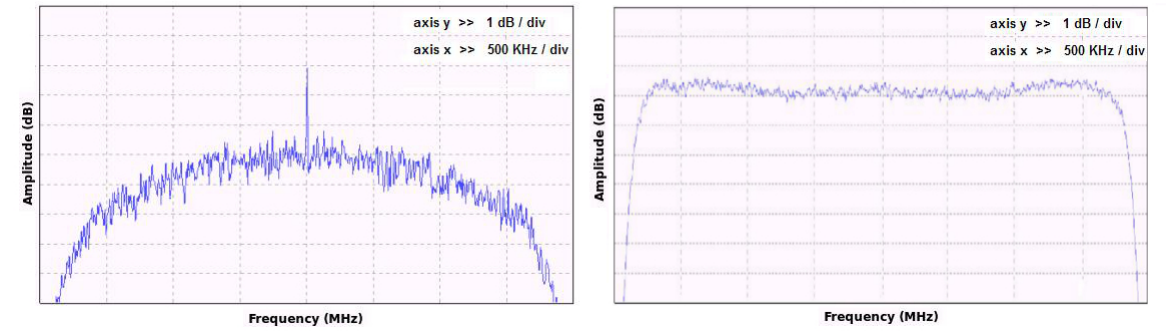
Figure 13. Frequency response before (left), and after equalization and DC cancellation.